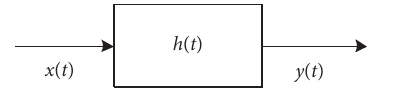
Figure 3: Transfer response for linear time-invariance